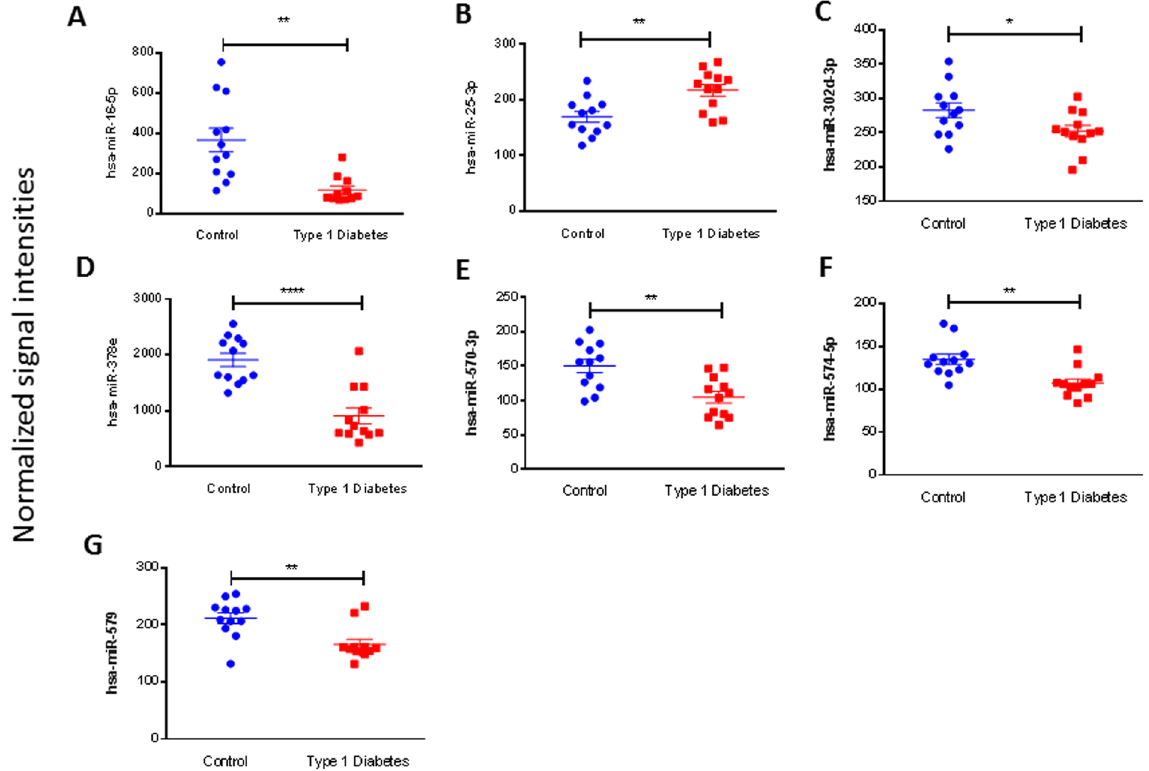
Figure 3. Differential microarray miRNA expression in T1DM and control subjects. Individual changes in the miRNA plasma exosome levels of the one up-regulated and six down-regulated miRNAs in T1DM patients (n = 12) and control subjects (n = 12). The signal intensities were normalized to the total signal intensity of the microarray. The horizontal lines indicate the mean normalized signal intensity for each group. Statistically significant differences were determined by Student’s